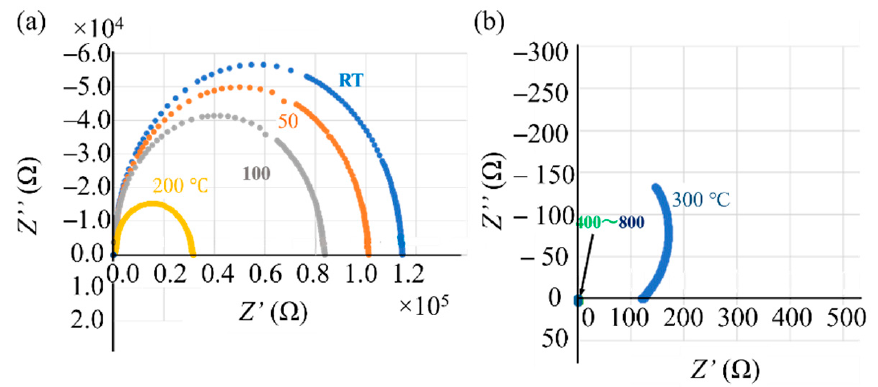
Figure 11. Nyquist diagrams of virgin Inconel 718 PA powder measured by alternating current (AC) impedance spectroscopy between room temperature (23 °C) and 800 °C: ( a ) Nyquist plots measured at room temperature and at 50, 100, and 200 °C; ( b ) Nyquist plots measured at 300, 400, and 800 °C (enlarged view).